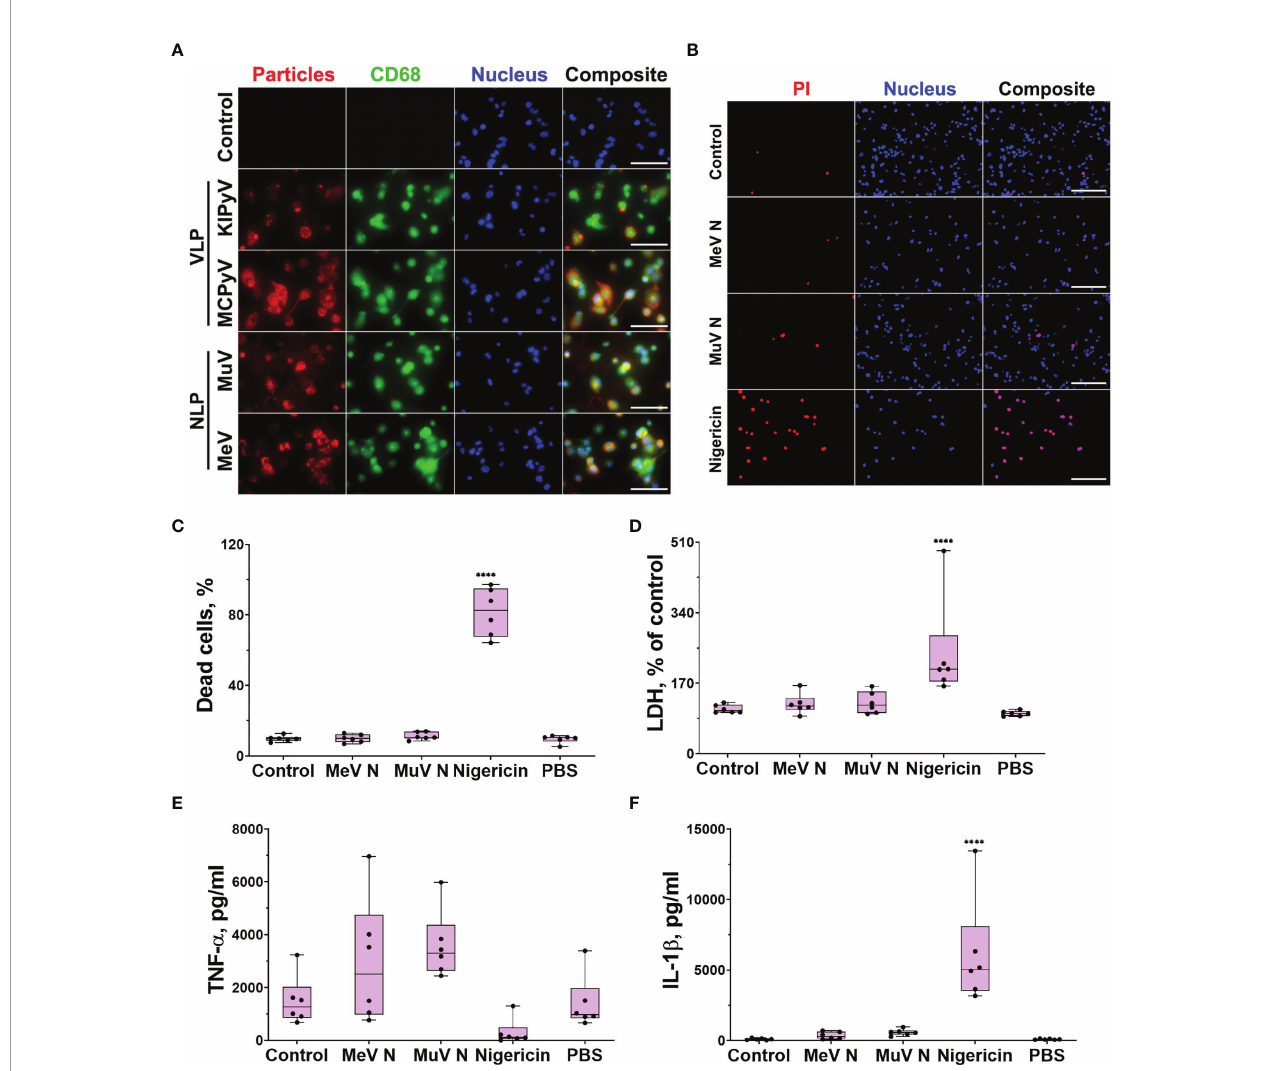
FIGURE 1 | PyV-derived VLPs and NLPs of measles and mumps viruses were taken up by THP-1 macrophages; however, NLPs did not induce cell activation. THP-1 macrophages were treated with recombinant viral proteins (20 µg/ml) for 24 h. Nigericin (10 m M) was used as a positive control. (A) Cells were immunostained with anti-NLP and anti-VLP monoclonal antibodies (red), anti-CD68 – macrophage and lysosomal marker (green), nuclear stain Hoechst33342 (blue) and analyzed by fl uorescence microscopy. The negative control – secondary antibody alone is referred as a control. Images were taken using 40× objective. The scale bars indicate 100 m m. Representative images of one experiment are shown. (B) PI (dead cells) and Hoechst (all cells) nuclear staining. Images were taken using 20× objective. The scale bars indicate 200 m m. (C) Quanti fi cation of dead cells. (D) Cytotoxicity assessed by LDH assay. (E) TNF- a and (F) IL-1 b secretion determined by ELISA. Data are represented using box plots, **** p < 0.0001, one-way ANOVA followed by Tukey ’ s multiple comparison test; stars show statistically signi fi cant results compared to